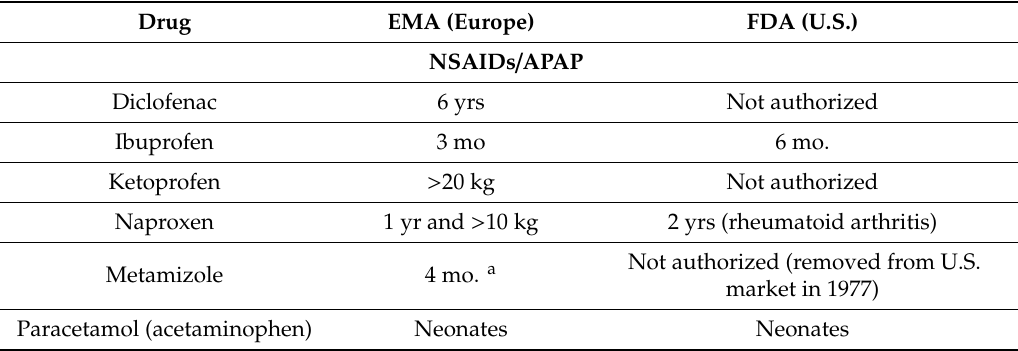
Table 1. Minimum age for common pediatric